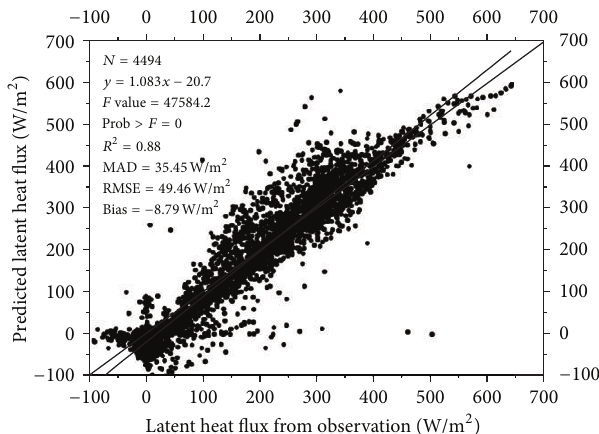
Figure 6: The latent heat flux (W/m 2 ) estimated from Landsat based variables.